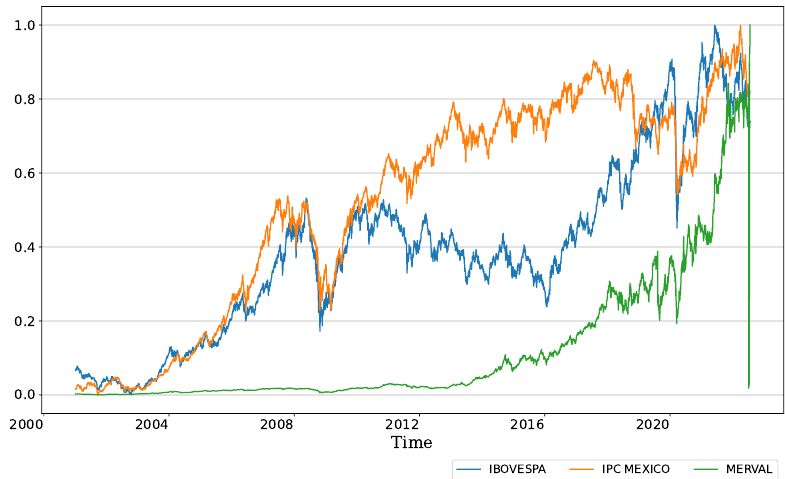
Figure A2. Evolutionary dynamics of South American financial market indices.